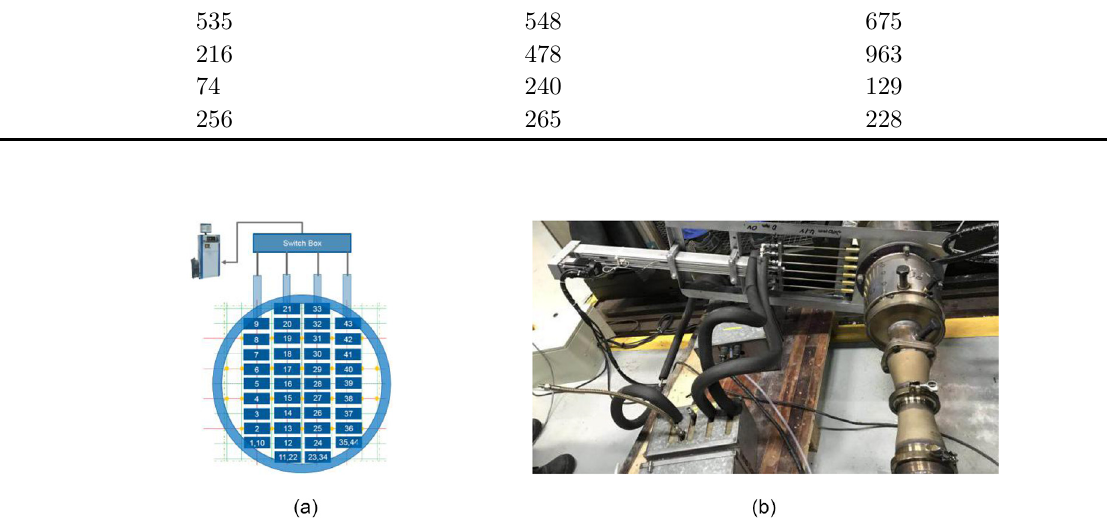
Table 2. Working conditions for calculation. Assessment point